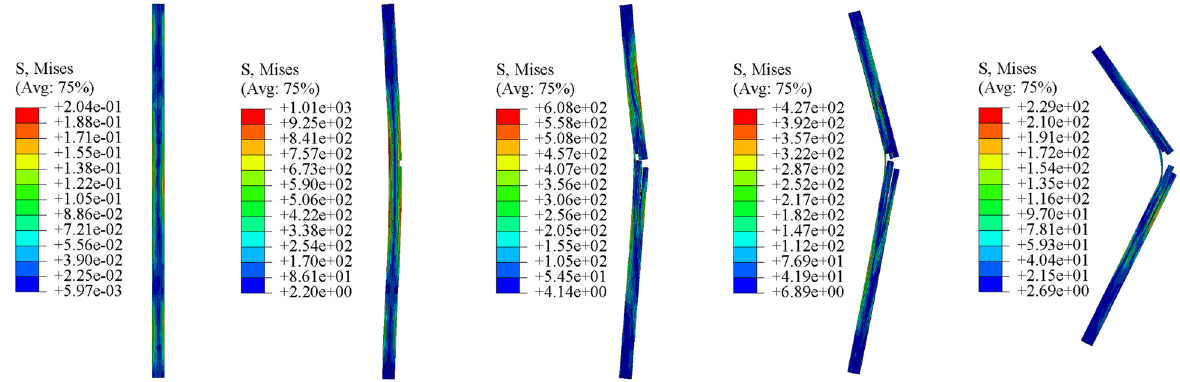
Figure 13. The stress nephogram of the FEA results of the dynamic bending sample applied at the impact velocity of 8.5 𝑚 𝑠⁄ .